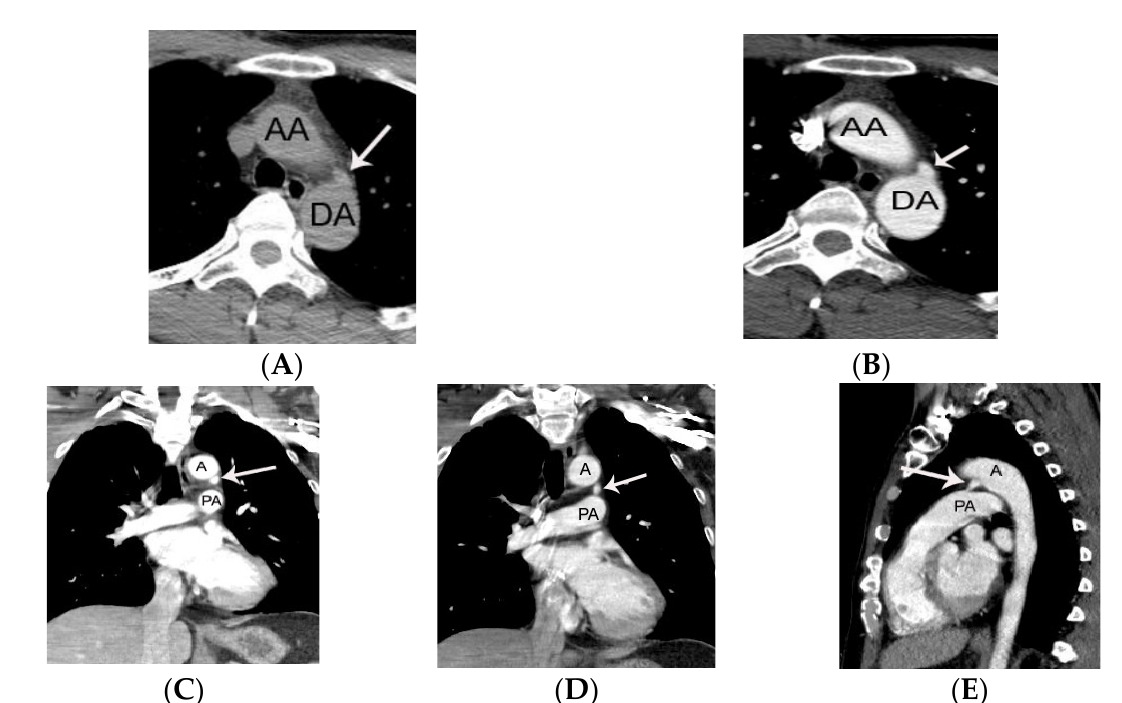
Figure 1. Representative case of small PDA initially diagnosed on non-gated chest CT in a 36-year-old male patient. A conically shaped protrusion (arrow on A , B ) of PDA arising from the descending thoracic aorta at the 12 o’clock position is noted at the level of trachea on an axial CT image. The absence of calcification argues against a calcified ligamentum arteriosum. Note that the PDA is more easily identified on coronal (arrow on C , D ) and sagittal CT images (arrow on E ). AA, DA, A, and PA indicate ascending aorta, descending aorta, aorta, and pulmonary artery, respectively.